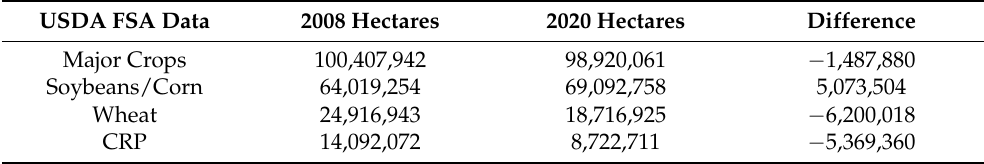
Table 3. USDA Farm Services Agency Total Hectares in Major Crops in 2008 and 2020 (major crops include barley, corn, cotton, oats, rice, sorghum, soybeans, sugar beets, sugarcane, and